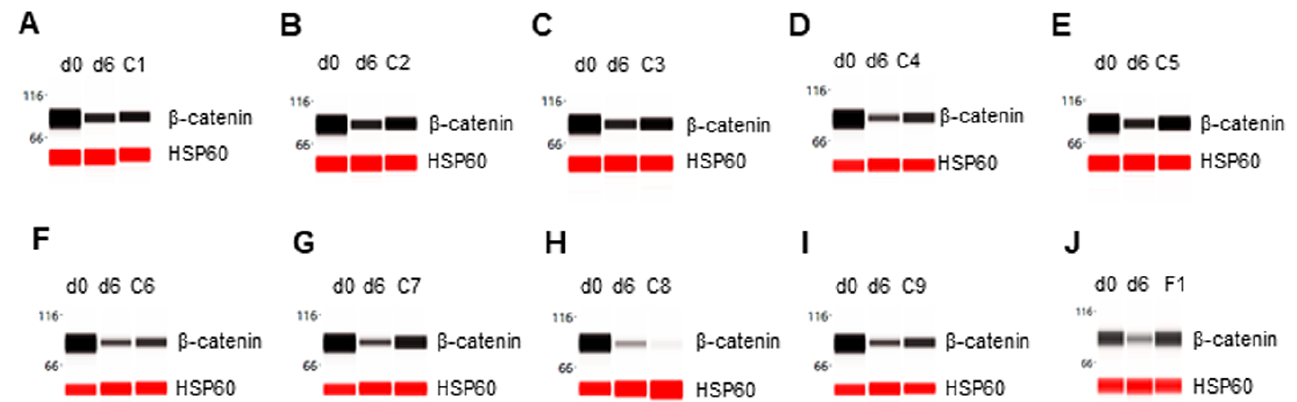
Figure 6. Inhibition of β -catenin degradation in differentiating preadipocytes. Expression level of β -catenin in preadipocytes on d0, d6 post-differentiation, or d6 post-differentiation in the presence of ( A ) berberine (C1), ( B ) luteolin (C2), ( C ) resveratrol (C3), ( D ) fisetin (C4), ( E ) quercetin (C5), ( F ) fucoidan (C6), ( G ) EGCG (C7), ( H ) hesperidin (C8), ( I ) curcumin (C9), or ( J ) F1 composition. β -actin served as a loading control. The protein expression level was measured using multiplexed capillary Western immunoassays. Molecular markers in kilodalton (kDa) are displayed on the left of the capillary Western immunoassay data. Table 1. Expression level of adipogenic biomarker proteins as functions of phytonutrients. Biomarkers